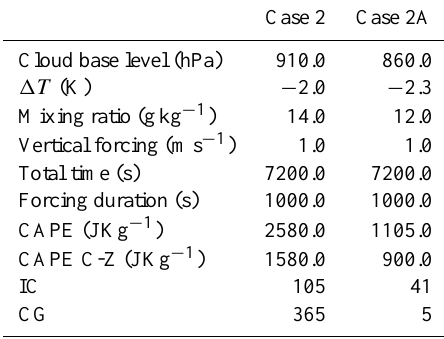
Table 1. Comparison of EMTM configuration and results for the sensitivity test for Case 2 (Rome, 2 July 2009). The following pa- rameters are considered: cloud base level (i.e., the condensation level of the initial cloud); 1T (i.e., the thermal disturbance with respect to the environment of the initial cloud); mixing ratio (i.e., the mixing ratio of the parcel at ground level, assuming that the dis- placement is dry adiabatic); vertical forcing (i.e., the imposed initial updraft); total time (i.e., the total duration of the simulation); forc- ing duration (i.e., the time extension of the forcing); CAPE (i.e., the Convective Available Potential Energy); CAPE C-Z (i.e., the CAPE calculated between 0 ◦ C and − 25 ◦ C levels); IC (i.e., the total amount of simulated intracloud lightning); CG (i.e., the total amount of simulated cloud-to-ground